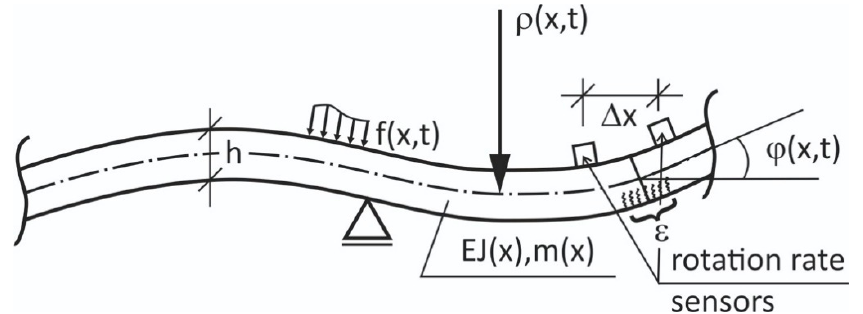
Figure 7. A beam with flexural, bending vibrations with curvature 1/r( x , t ), with its part monitored using two rotation rate sensors at a distance of ∆ x